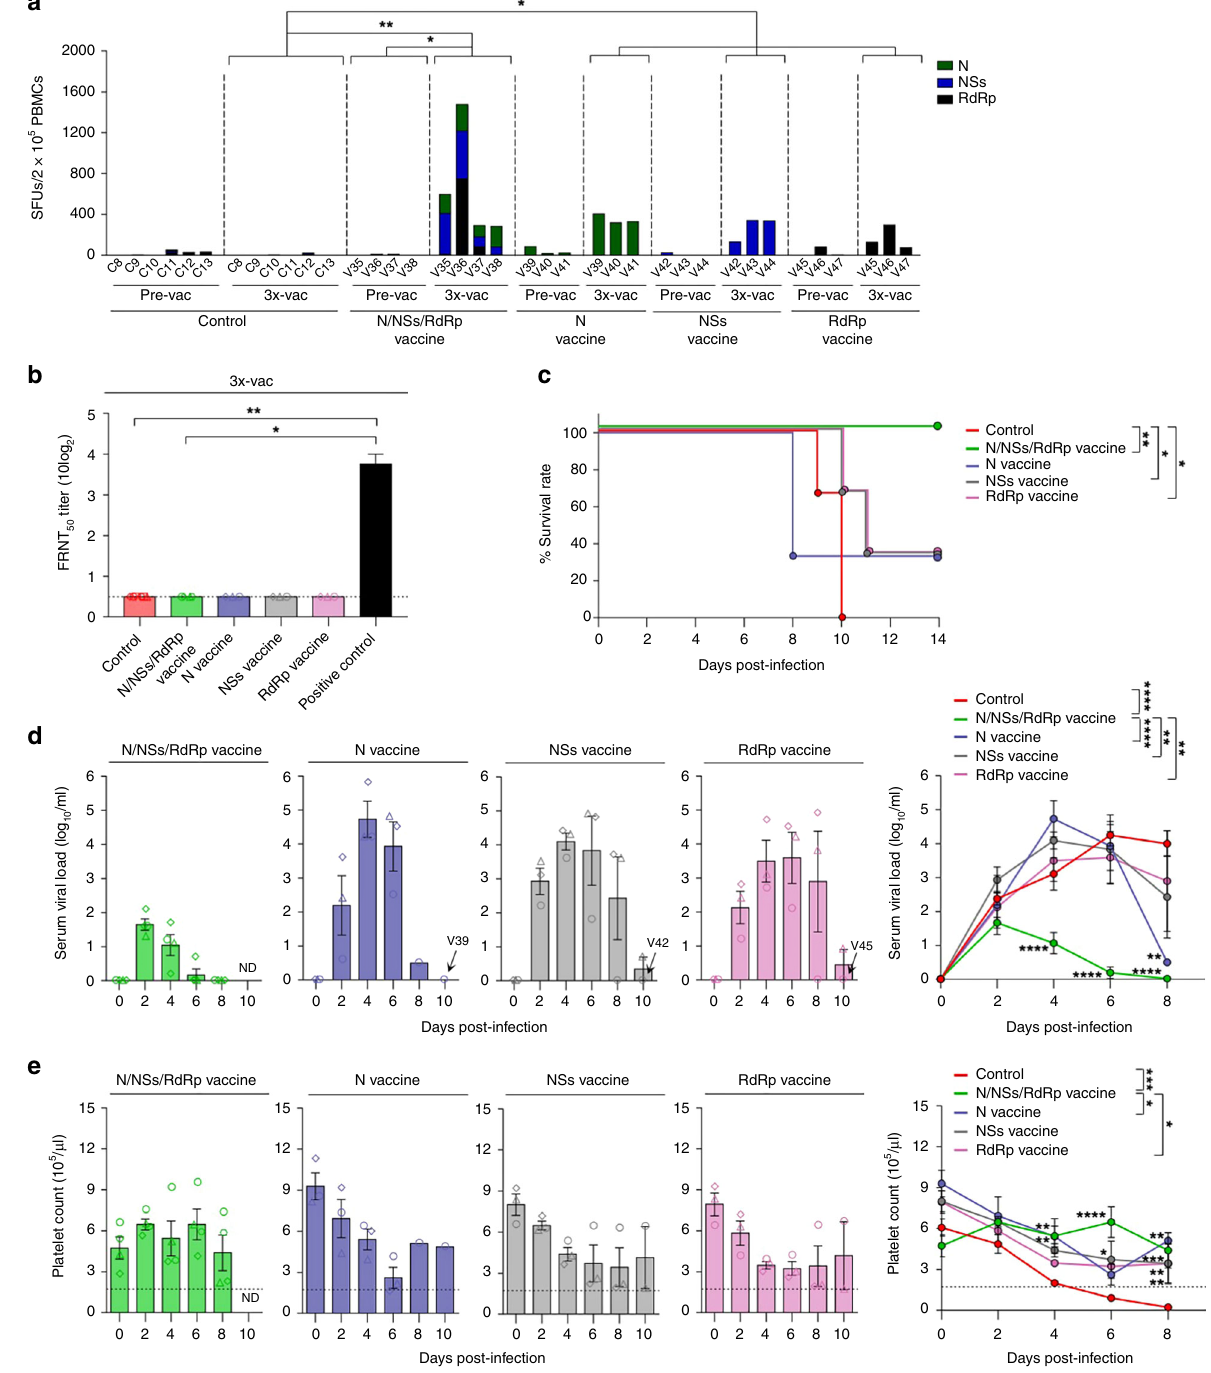
Fig. 4 N/NSs/RdRp-speci fi c T-cell responses can protect ferrets against lethal challenge. a T-cell immunogenicity of SFTSV DNA vaccines in ferrets. IFN- γ ELISpot assays were performed to detect antigen-speci fi c IFN- γ -producing T cells by stimulating PBMCs from vaccinated or non-vaccinated (control) ferrets with OLP pools covering N, NSs, and RdRp. Data represent the average number of SFUs per 2 × 10 5 PBMCs. b Neutralizing antibody response to SFTSV CB1/2014 strain (genotype B) generated by DNA vaccines in ferrets. The amount of neutralizing antibody against SFTSV was determined based on FRNT 50 . c Survival of N/NSs/RdRp- ( n = 4, green line), N- ( n = 3, indigo line), NSs- ( n = 3, gray line), or RdRp- ( n = 3, pink line) vaccinated and non- vaccinated control ( n = 6, red line) ferrets after lethal SFTSV challenge. d Circulating viral titers of N/NSs/RdRp- (green bars, symbols and line), N- (indigo bars, symbols, and line), NSs- (gray bars, symbols and line), or RdRp- (pink bars, symbols, and line) vaccinated ferrets after SFTSV challenge. e Platelet counts in N/NSs/RdRp- (green bars, symbols, and line), N- (indigo bars, symbols, and line), NSs- (gray bars, symbols, and line), or RdRp- (pink bars, symbols, and line) vaccinated ferrets after SFTSV challenge. The normal platelet count range in ferrets is 171.7 – 1280.6 × 10 3 per μ L. Dashed lines indicate normal platelet count values. Data are presented as mean ± s.e.m. Asterisks next to the symbols on graphs indicate signi fi cance between vaccinated and control ferrets per dpi. Asterisks next to the group labels indicate signi fi cance between groups indicated. ND, not determined due to the sample unavailability. Statistical signi fi cance was determined by two-tailed Mann – Whitney U- test ( a , b ), log-rank (Mantel-Cox) test ( c ), two-way ANOVA test with Sidak correction ( d , e ). *p < 0.05 ; **p < 0.01 ; ***p < 0.001 ; ****p < 0.0001. Source data are provided as a Source Data fi